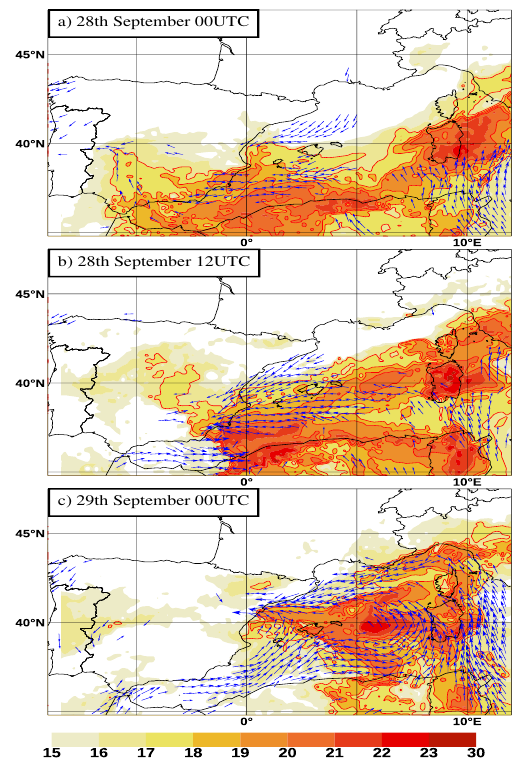
Figure 21. Wind at 925 hPa (blue arrows in excess of 20ms − 1 ) and wet bulb temperature ( ◦ C, colour scale) at 925hPa from AROME- WMED